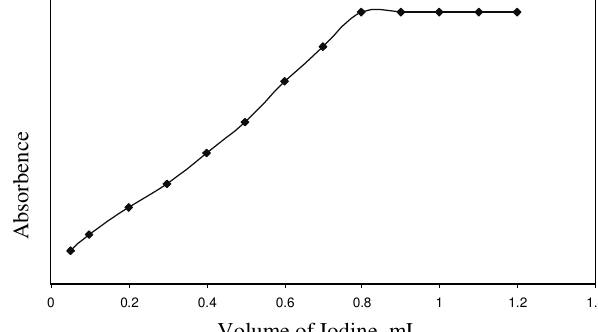
Figure 3. Effect of iodine concentraction; (Keeping constant 0.18 mL of 0.5 µg/mL